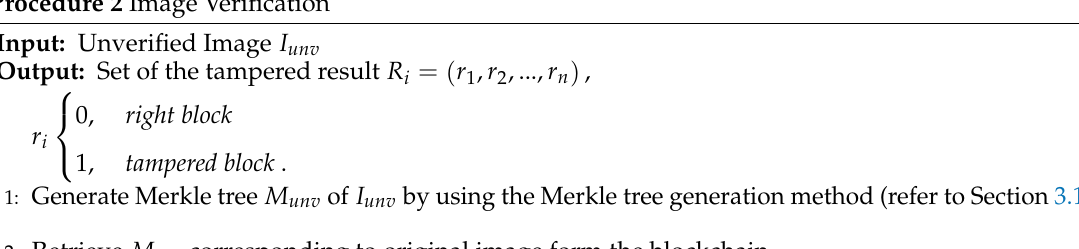
Procedure 2 Image